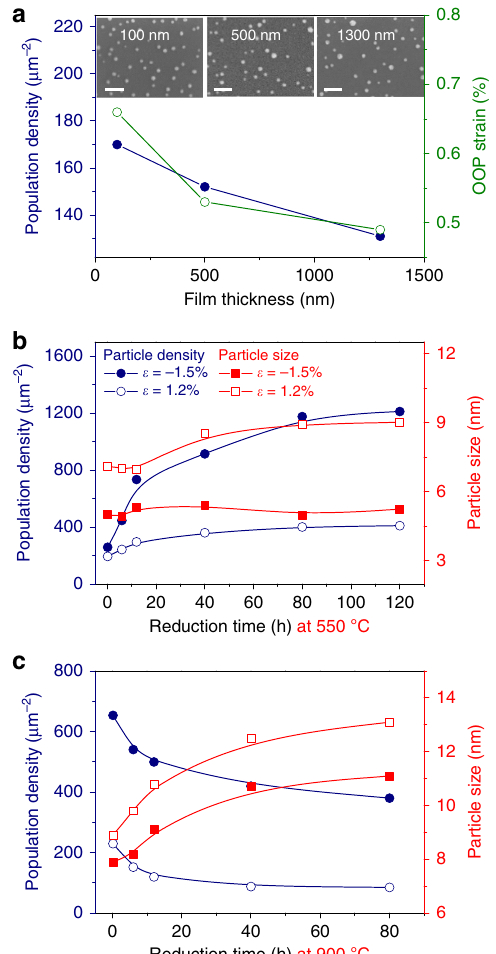
Fig. 3 Thickness- and time-dependent exsolution. a Population density of exsolved particles and out-of-plane (OOP) strain of the LSNT fi lm grown on the STO substrate as a function of the fi lm thickness after the reduction at 900 °C for 12 h. Population density and particle size as a function of the reduction time (10 min, 6 h, 12 h, 40 h, 80 h, and 120 h) at b 550 °C and c 900 °C, respectively, for ε = − 1.5% (LSNT/LSAT) and ε = + 1.2%